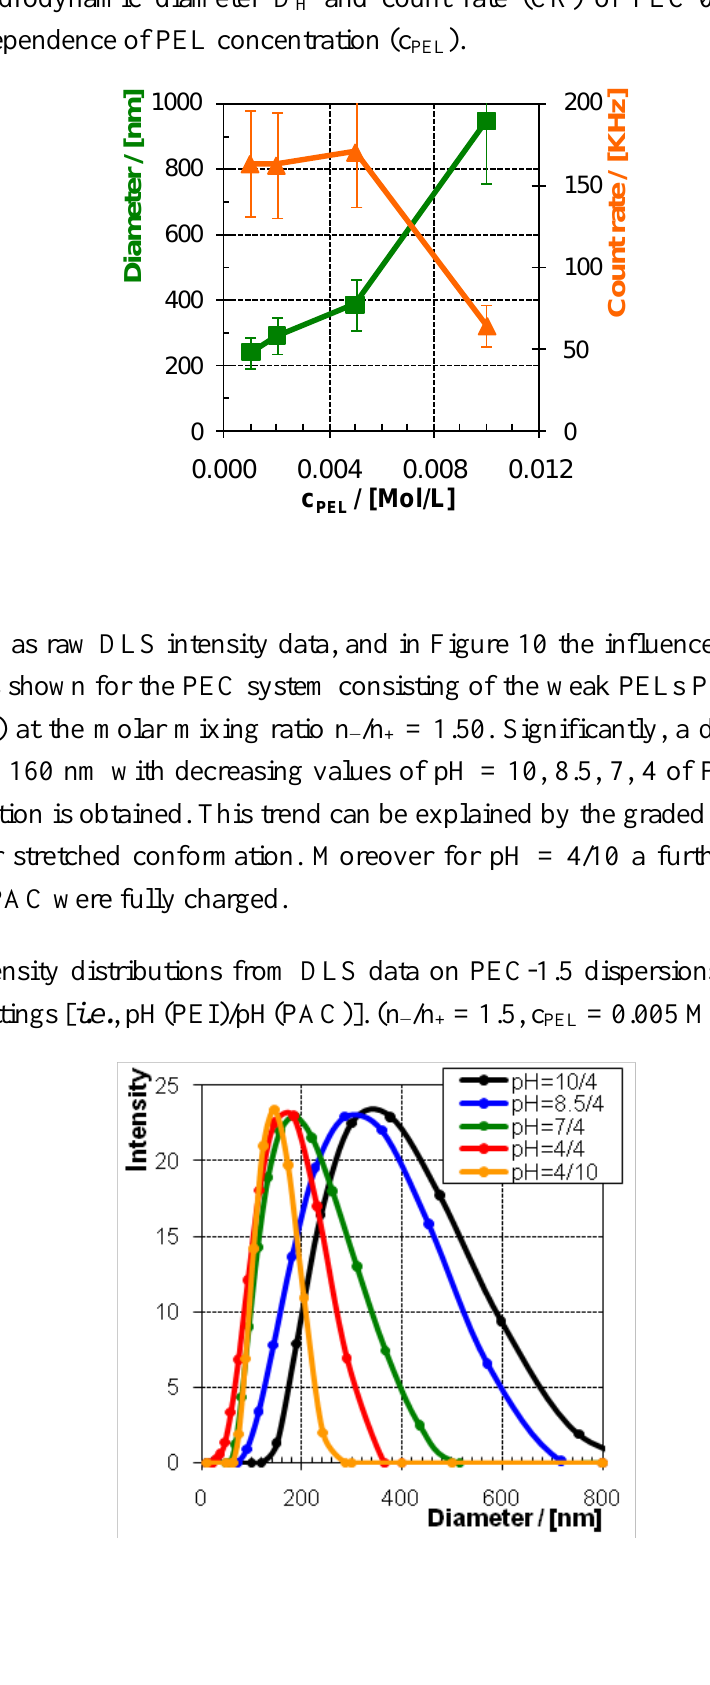
Figure 8. Hydrodynamic diameter D PEI/PAC in dependence of PEL concentration (c